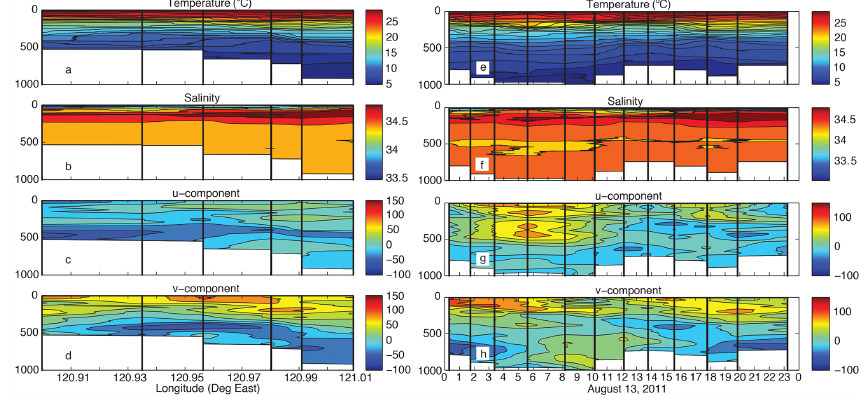
Figure 2. CTD and LADCP data for a zonal section along 21 ◦ 34.1 (cid:48) N (left panels) and the time-series station AE at 21 ◦ 34.1 (cid:48) N, 120 ◦ 59.1 (cid:48) E (right panels). The vertical solid lines represent the times and locations of the individual CTD/LADCP casts.